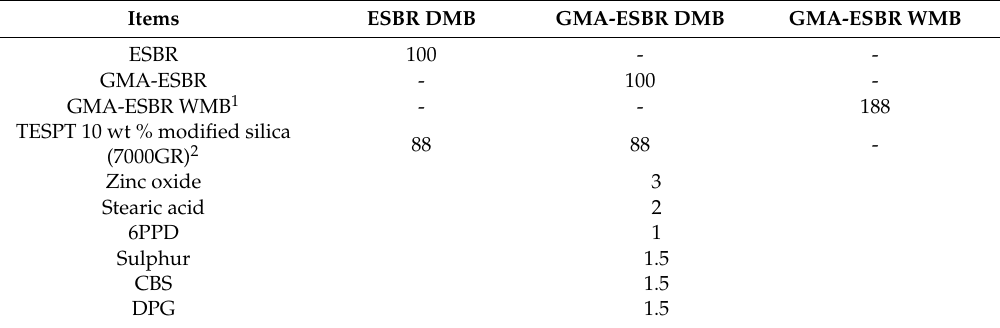
Table 2. Experimental formulation for rubber compounds (phr).